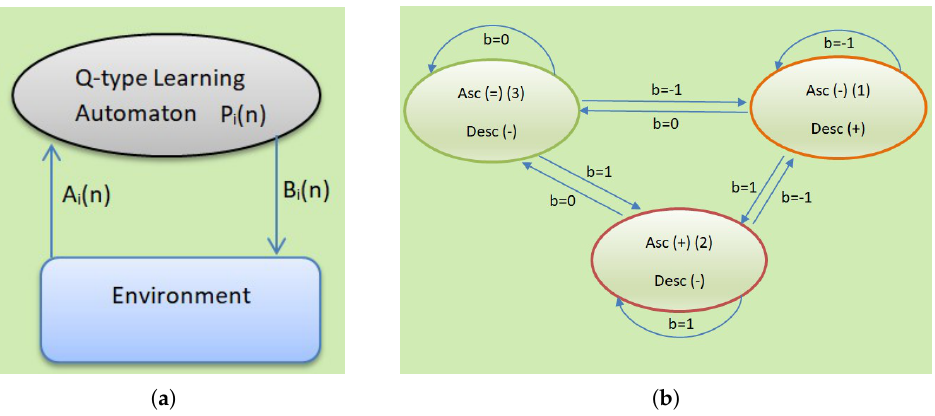
Figure 4. Learning automaton state principles and statechart. ( a ) Typical learning automaton interaction. ( b ) Learning automaton statechart with all the state